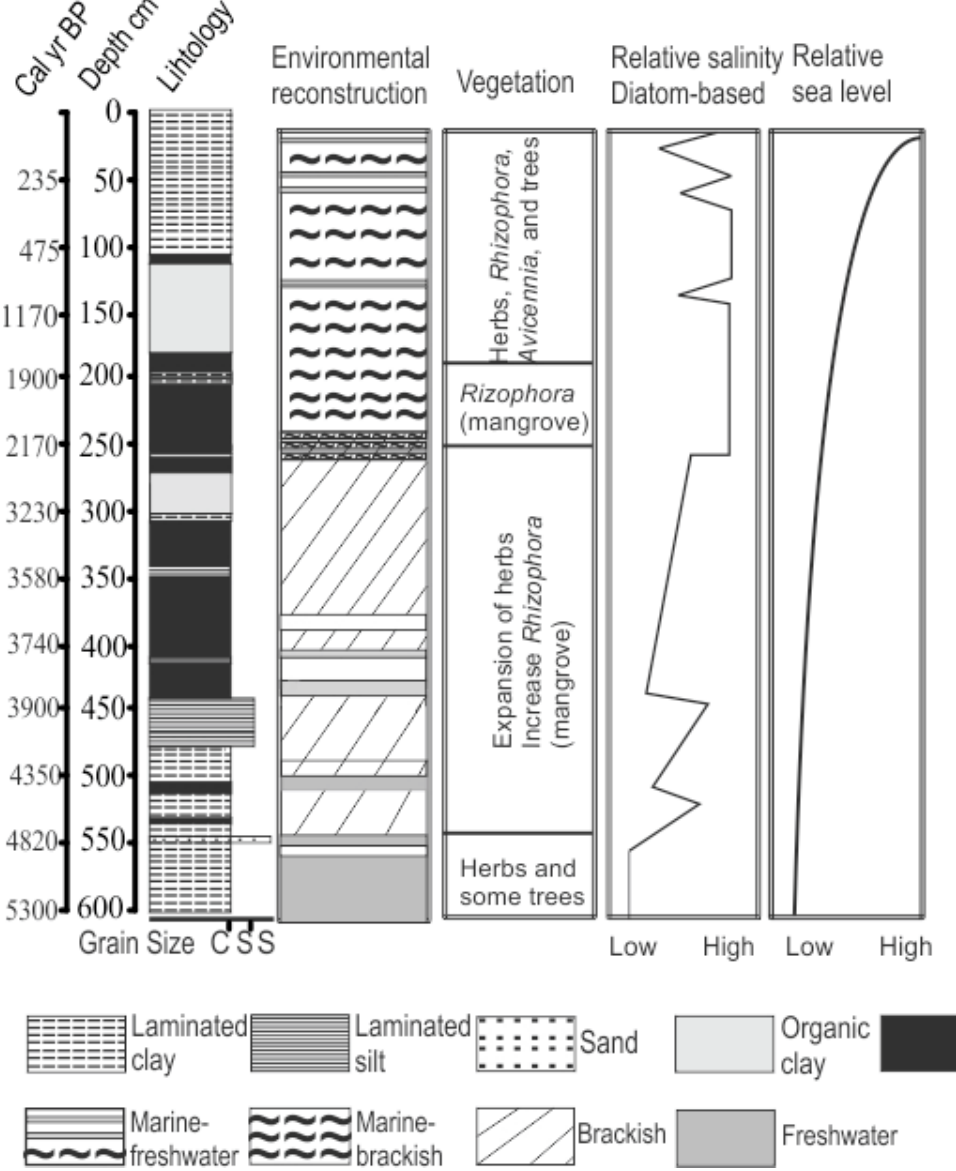
Figure 4. Holocene paleoenvironmental reconstruction of the Ciénaga Grande de Santa Marta (CGSM) modified from [29]. Pollen-based vegetation reconstruction was based on [31], and relative changes in salinity and sea level were re-interpreted from [30].